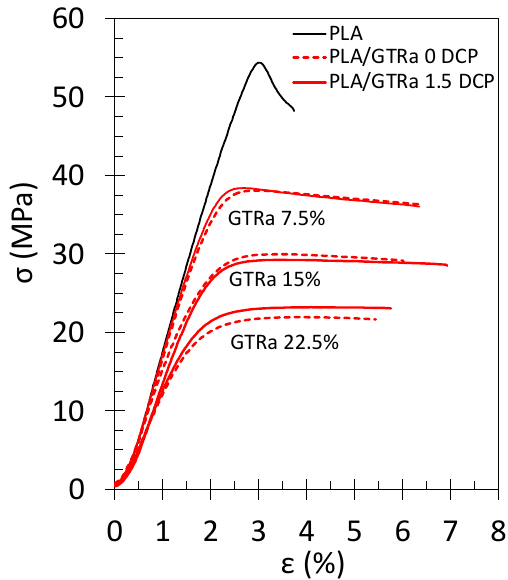
Figure 7. Engineering stress–strain curves of tensile test performed at 10 mm · min − 1 and at room temperature on the neat PLA without DCP (black continuous line), PLA/GTR a 7.5, 15 and 22.5% sieved 120’s mesh without DCP (red dotted lines) and PLA/GTR a 7.5, 15 and 22.5% sieved 120’s mesh with 1.5 wt% DCP (red continuous line). All blends were processed at 170 °C in presence of Irganox (0.2 wt% of total amount of material).